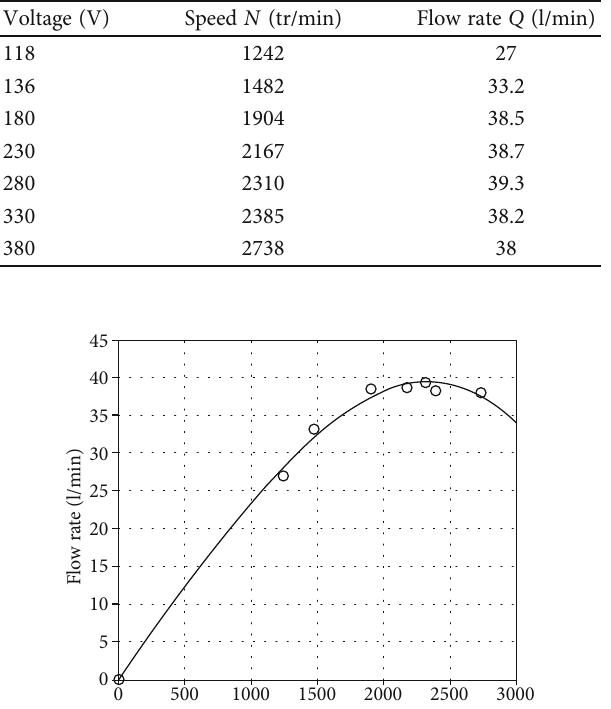
Table 3: Measurement of fl ow under supply voltage variation. Voltage (V)